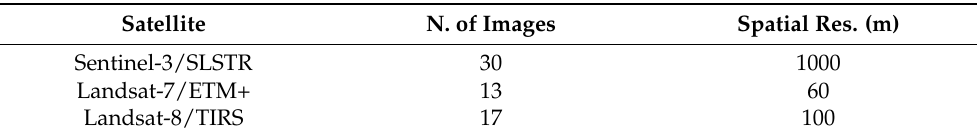
Table 10. Summary of characteristics of the dataset for comparing WST derived from Landsat and Sentinel-3 data from 2016 to 2019.